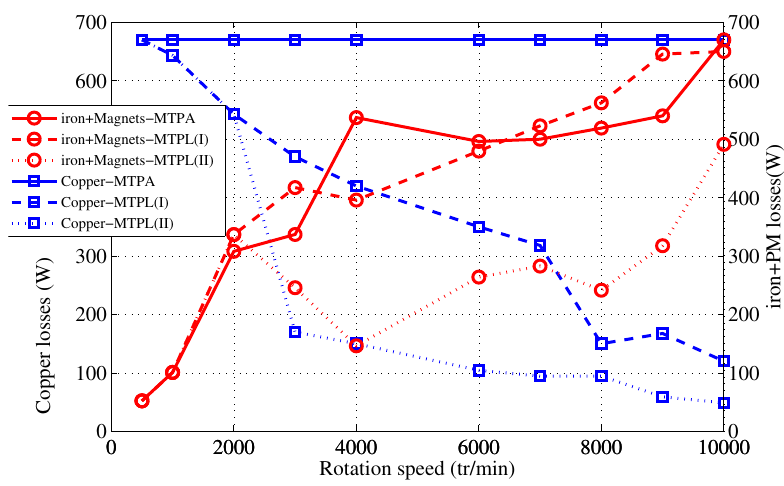
Figure 9. Copper losses, PM and iron losses versus speed.